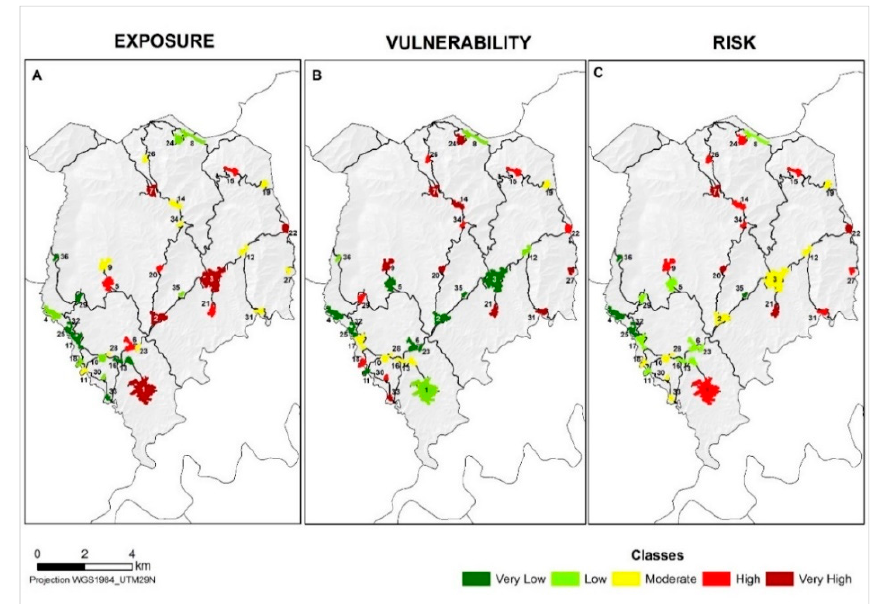
Figure 5. Classes of exposure ( A ), vulnerability ( B ), and risk ( C ) in the BAU scenario (Sc0) for the settlements of the civil parish of Alvares.